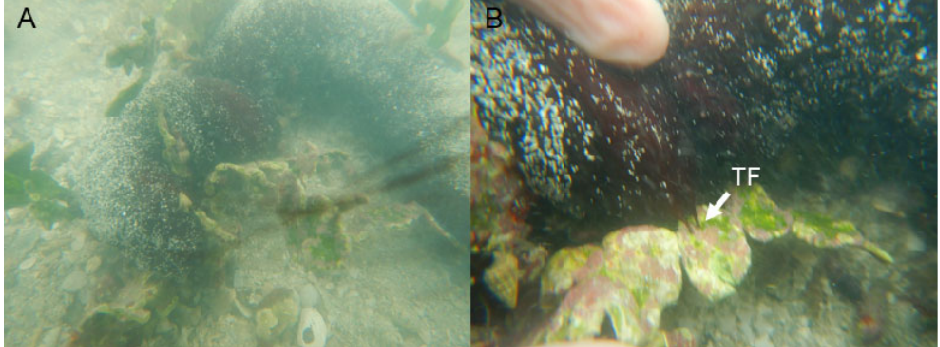
Figure 10. Using its tube feet (TF), H. atra holds H. macroloba to help twist its body ( A , B